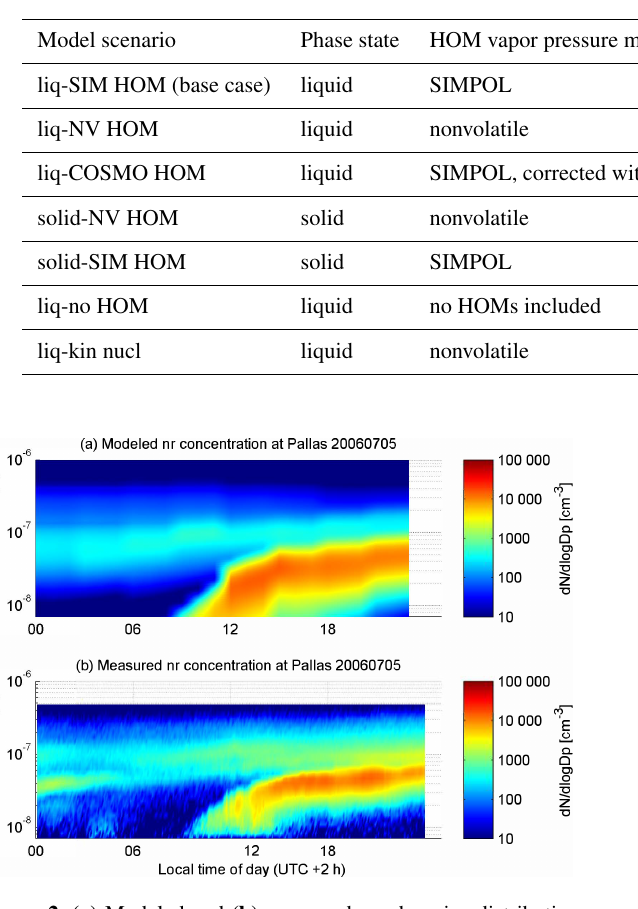
Table 1. Different assumptions for the different model scenarios tested in this study.